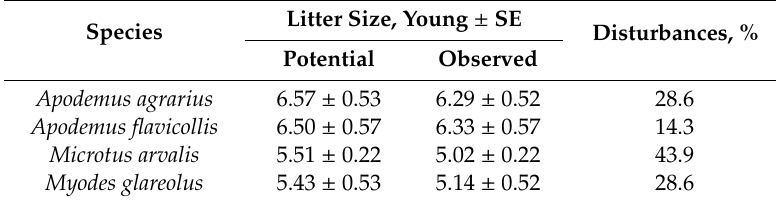
Table 6. Breeding data of most abundant small mammals from commercial orchards (recalculated from